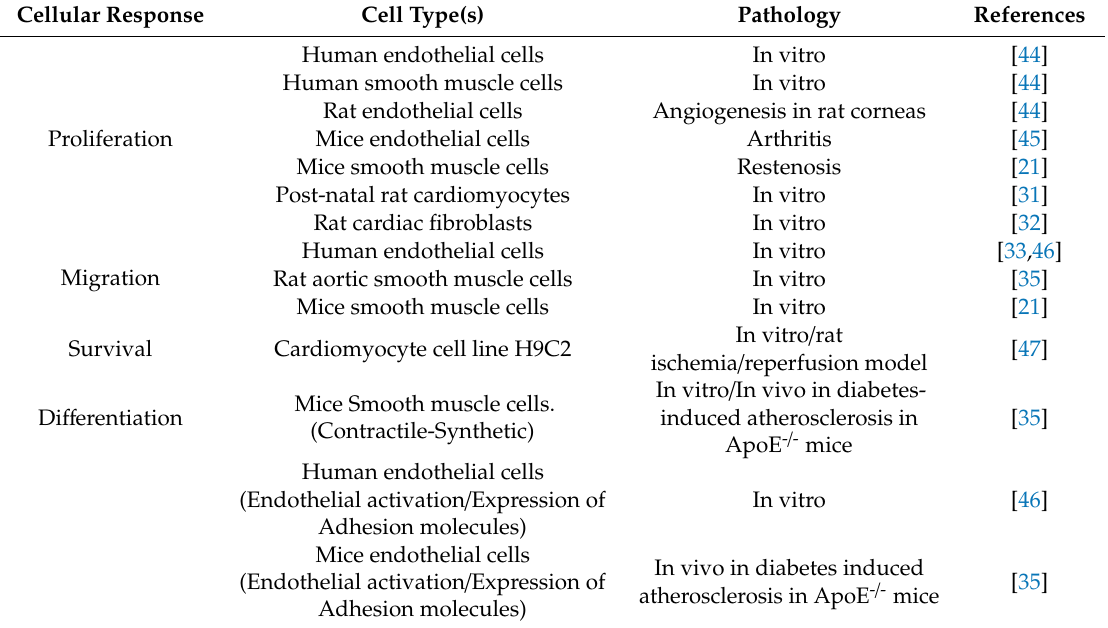
Table 1. TWEAK is a multifactorial cytokine that regulates biological processes in di ff erent cardiac and vascular cell